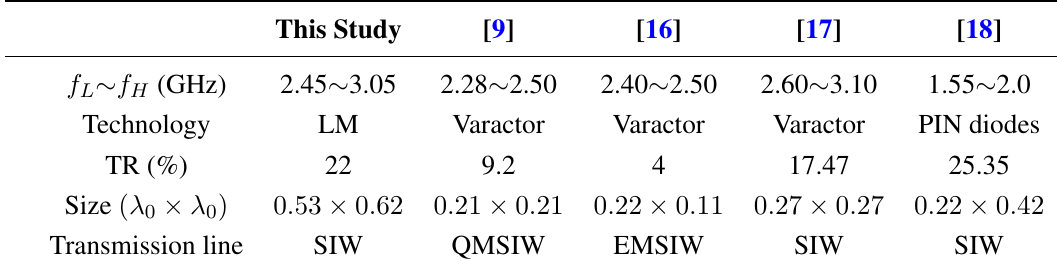
Table 4. Performance comparison of the proposed resonator with other reconfigurable SIW